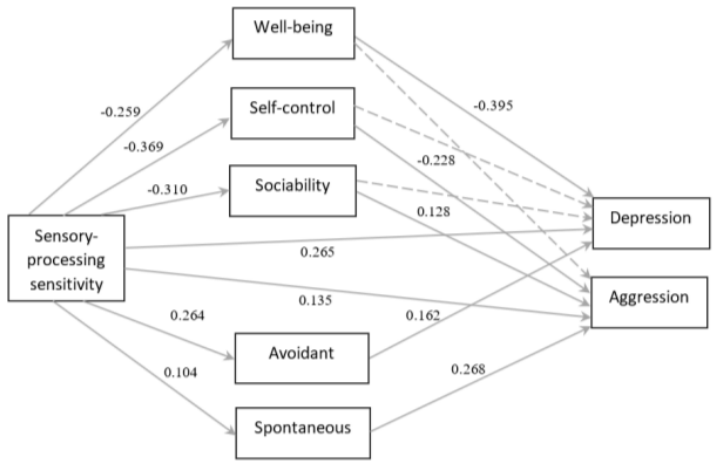
Figure 2. Results for the path analysis on the total sample. Entries are standardized regression weights. Discontinuous lines represent nonsignificant paths. Non-Normed Fit Index TLI = 0.953; Comparative Fit Index CFI = 0.992; root mean square error of approximation RMSEA = 0.056; chi-square χ 2 (5) = 9.253, p >